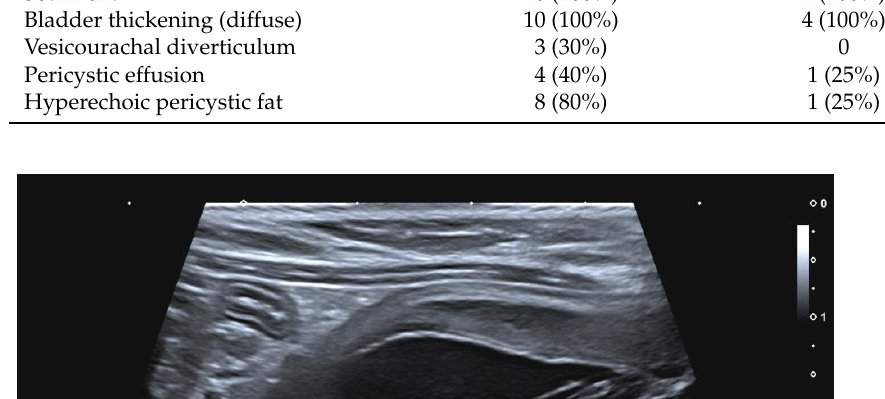
Figure 1. Ultrasound images of the urinary bladder showing the different types of adhesion pattern in three cats (image a , b , c ) and one dog (image d ). ( a ) Type 1; ( b ) Type 2; ( c ) Type 3; ( d ) Type 4. Diffuse bladder wall thickening and intraluminal echogenic sediment were present in all the cats and dogs (Table 2).